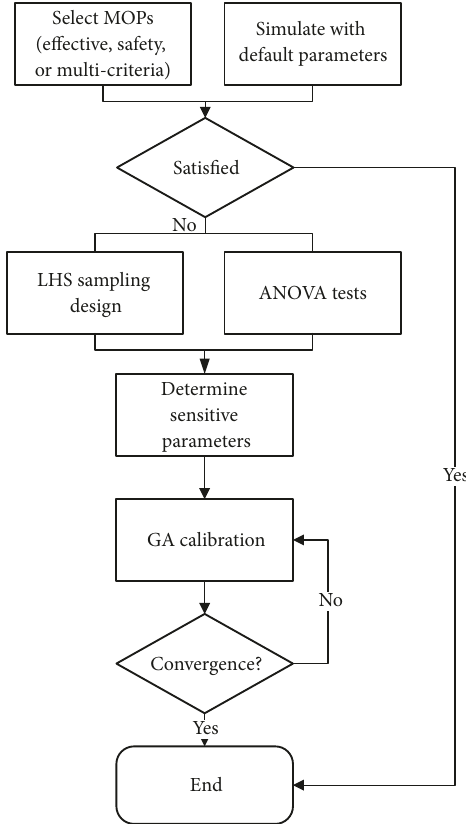
Figure 2: A general simulation calibration procedure applied in the